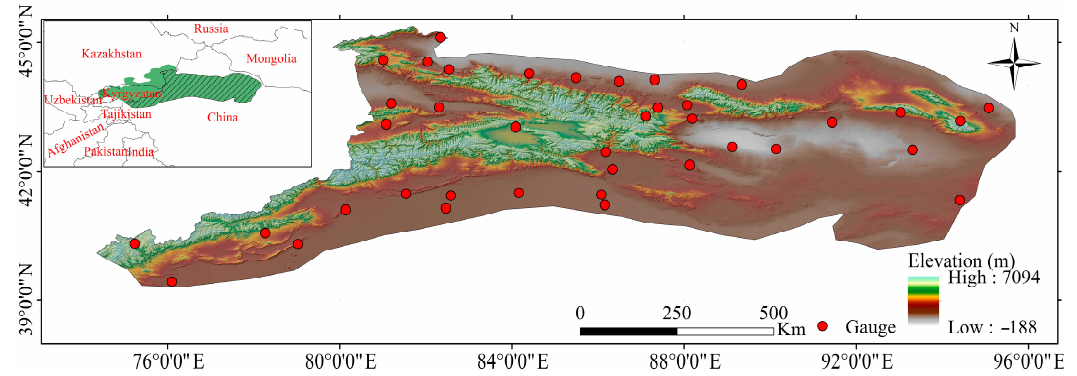
Figure 1. Geographical extents of Tianshan Mountains along with topography and locations of available gauging